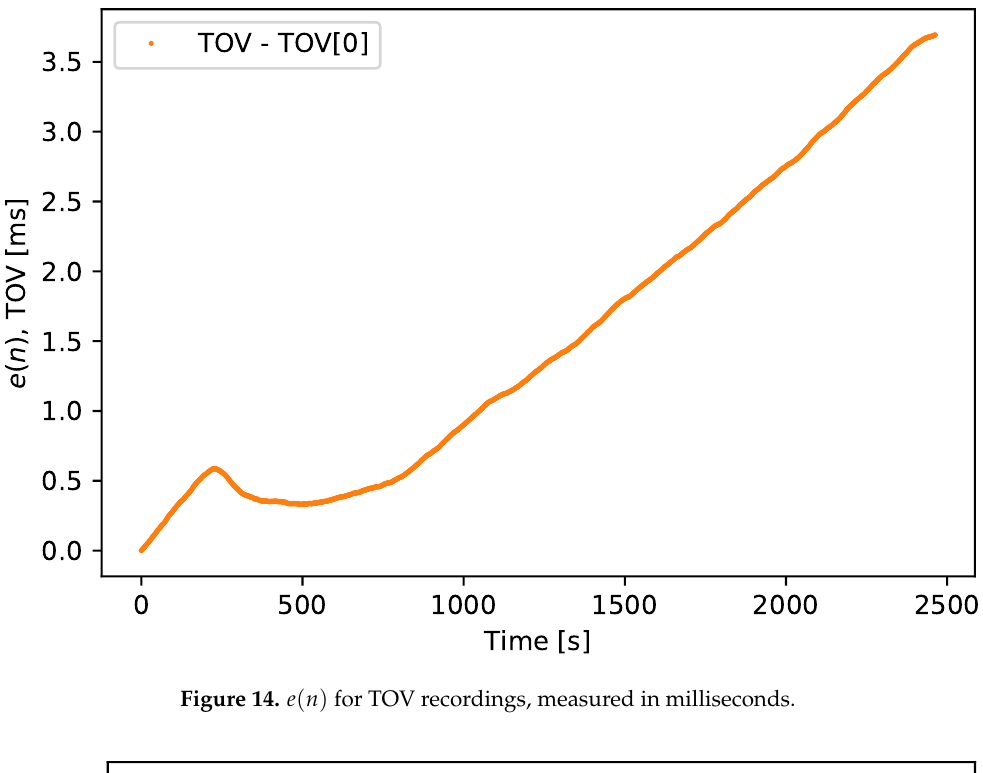
Figure 14. e ( n ) for TOV recordings, measured in milliseconds.